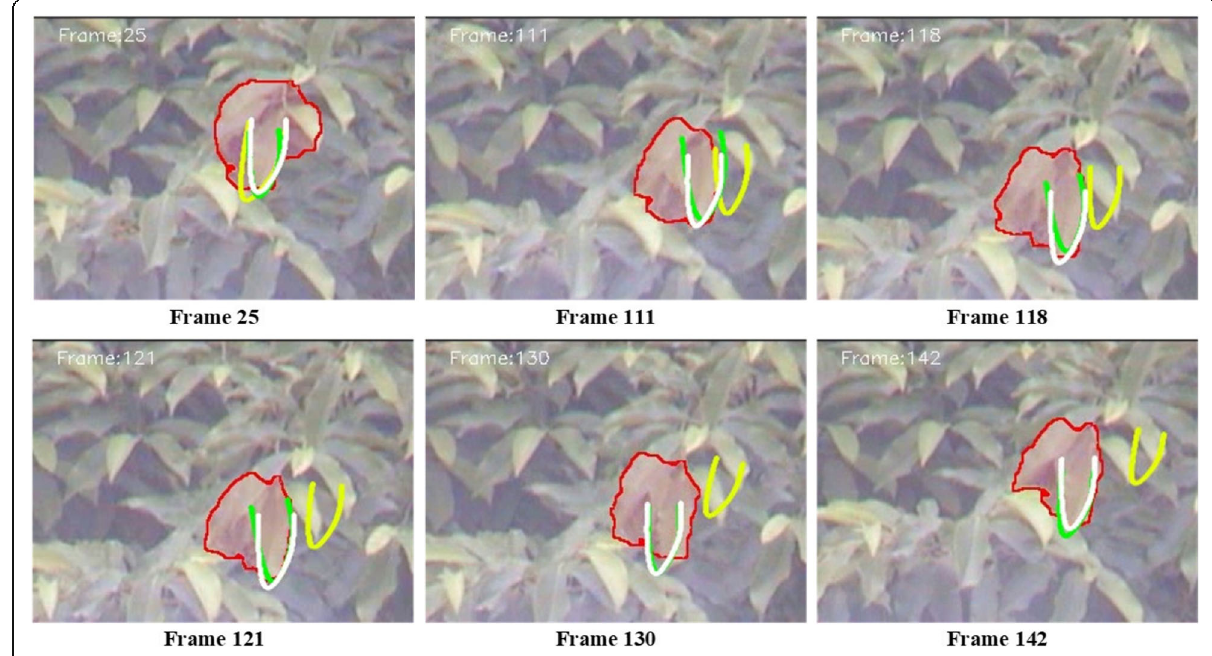
Fig. 7 Tracking result of Leaf1. Yellow — UKPF, white — MHMM-UPF, red — Hough Tracker, green — proposed method